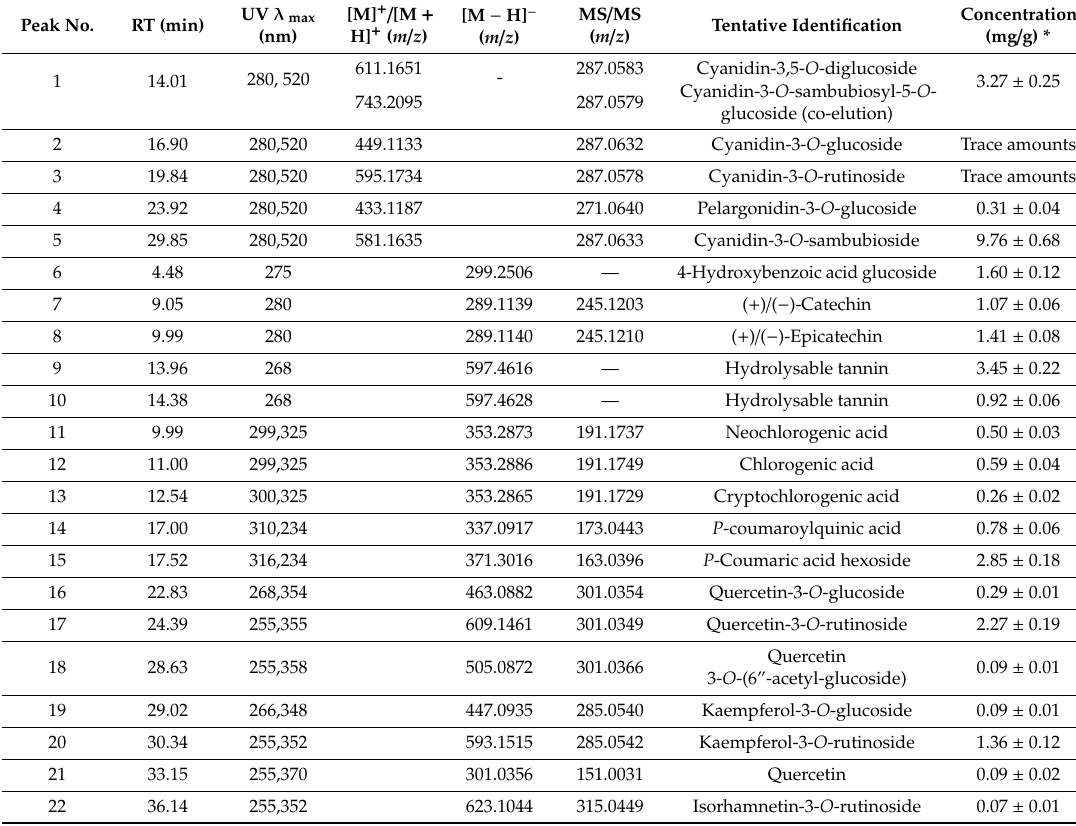
Table 2. HPLC-MS identification of phenolic compounds in elderberry fruit extract in positive (electrospray ionization (ESI) + ) and negative (ESI − ) ionization mode. Peak No. Tentative Identification